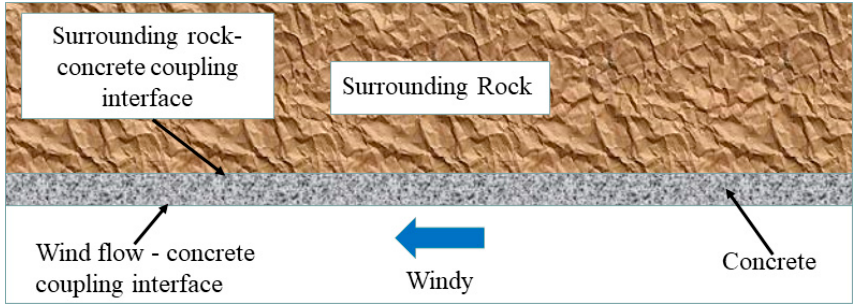
Figure 16. Heat transfer schematic.